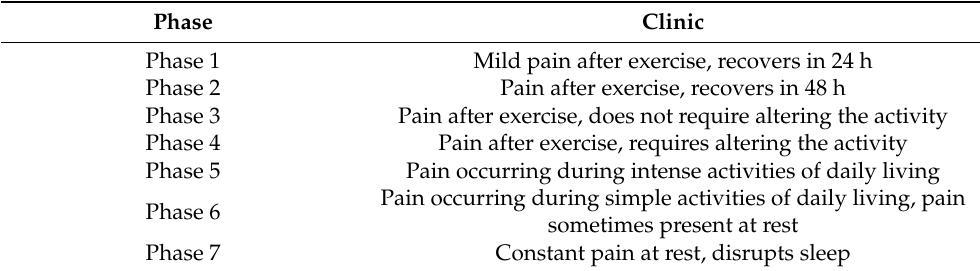
Table 1. Nirschl lateral epicondylitis pain evaluation